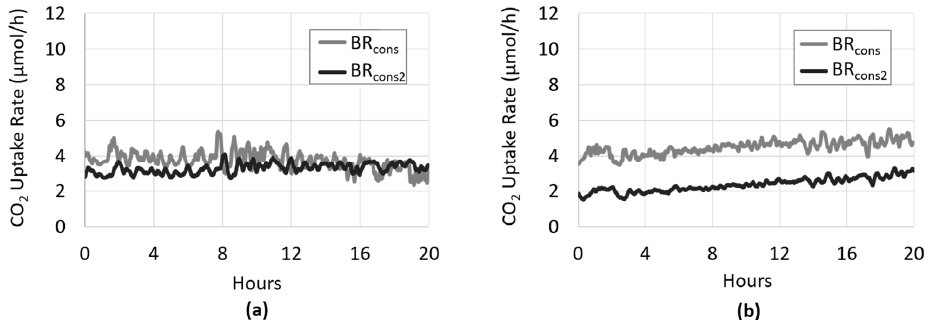
Figure 9. The CSMS was amended with an additional biofilm reactor (BR cons2 ) downstream of BR cons . The gas stream in the system was sequential, with the sweeper gas flowing from Analyzer 2, through the annular space of BR cons2 to a third CO 2 analyzer (Analyzer 3). ( a ) Initially, BR cons and BR cons2 were each inoculated with the photoautotrophic culture separately and received its own fresh feed of growth medium. In this configuration, the CO 2 uptake rate within BR cons and BR cons2 were approximately the same, meaning that the presence of a second photoautotrophic biofilm roughly doubled the system’s overall CO 2 -sequestering capacity. ( b ) Subsequently, the system was configured such that both medium and gas passed sequentially from BR cons to BR cons2 , producing a biofilm the length of two BRs. In this case, the CO 2 uptake rate in the first half of the biofilm (BR cons ) is higher than the second half of the biofilm (BR cons2 ), likely due to the depletion of some key nutrient(s) by the time the growth medium reached BR cons2 .